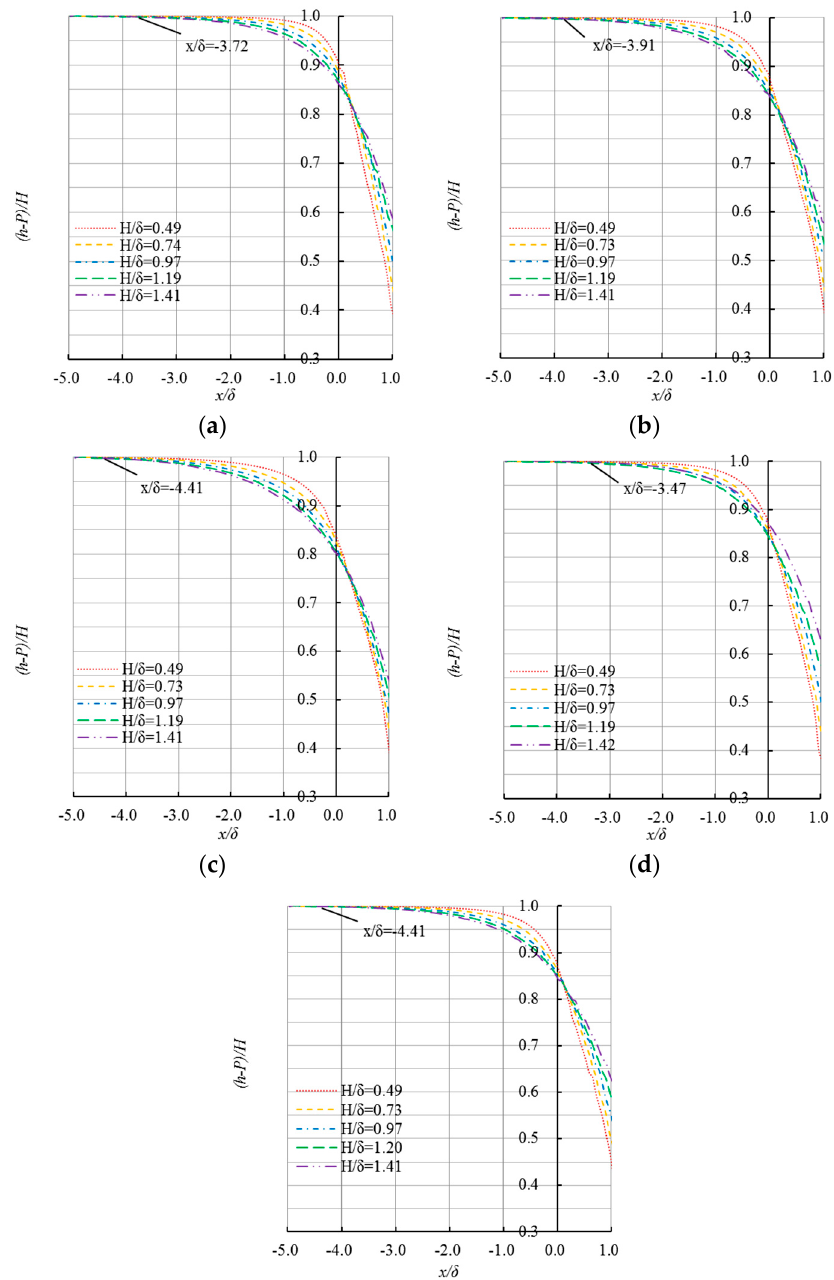
Figure 13. ( h − P )/ H vs. various x / δ for H / δ = 0.49–1.42 at: ( a ) S 1 = 0.0, S 2 = 0.8; ( b ) S 1 = 1.0, S 2 = 0.8; ( c ) S 1 = 2.0, S 2 = 0.8; ( d ) S 1 = 1.0, S 2 = 0.0; ( e ) S 1 = 1.0, S 2 = 2.0.